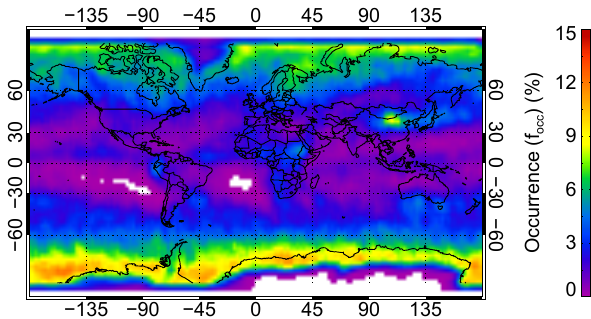
Figure 1. Global distribution of single-layer mid-level stratiform cloud occurrence frequency from 4 years of collocated CALIOP and CPR measurements. Figure 2. The probability distribution function (PDF) of LWP for